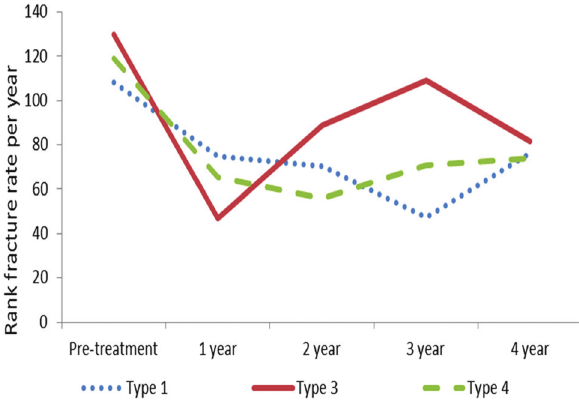
Figure 1 - Fracture rate in the sample and according to OI type.